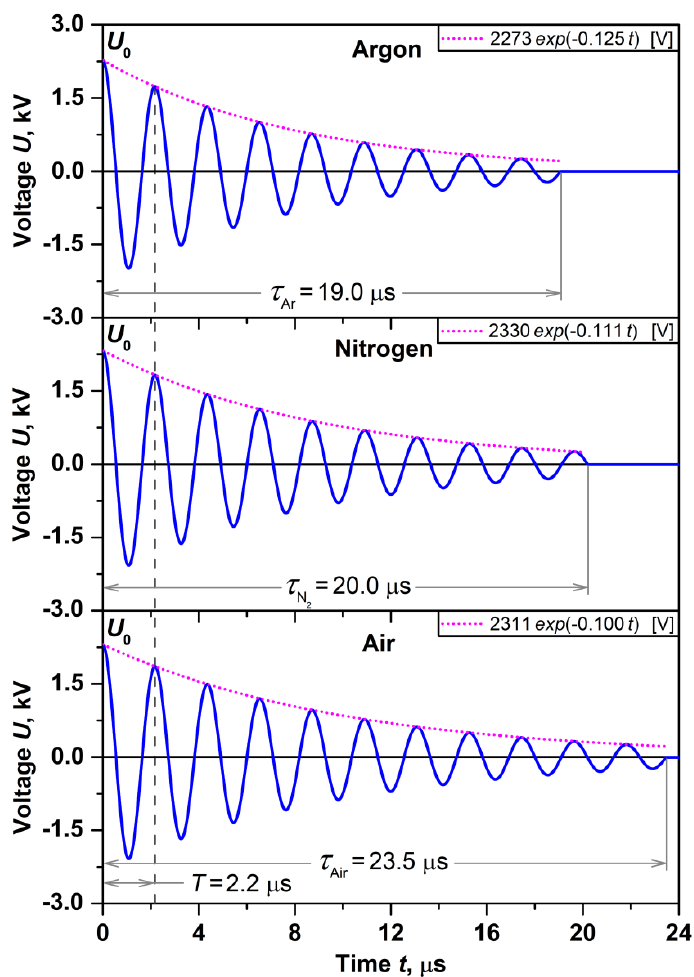
Figure 8. Oscillograms of voltages U ( t ) measured between platinum electrodes during a spark discharge under Ar, N 2 and air.